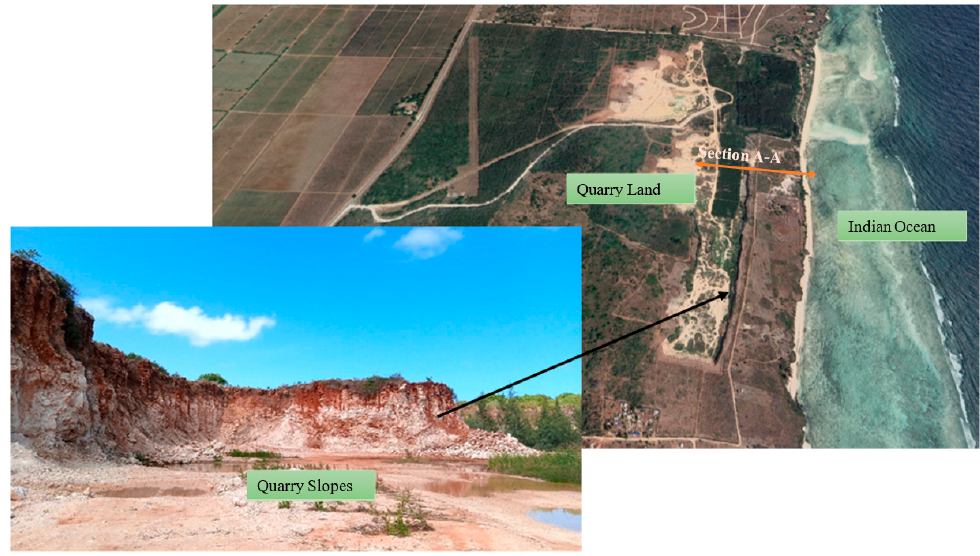
Figure 4. The quarry environment.